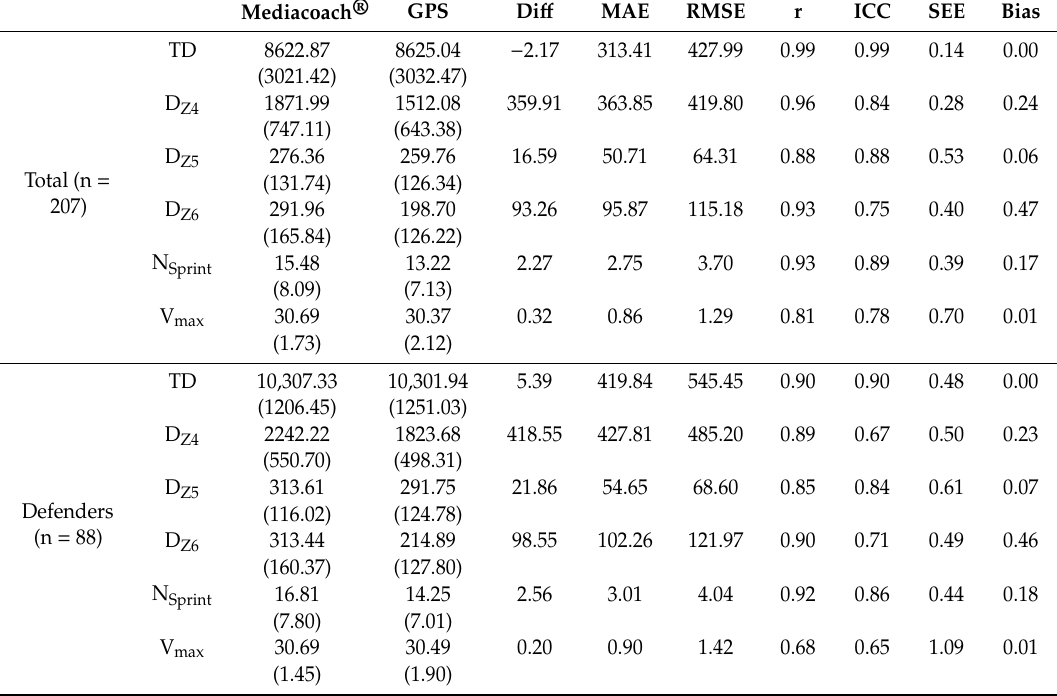
Table 1. Validity for the distances, velocity, and number of sprint measurements recorded by both the Global Positioning System (GPS) devices and Mediacoach ® during a match, according to the playing position (n =